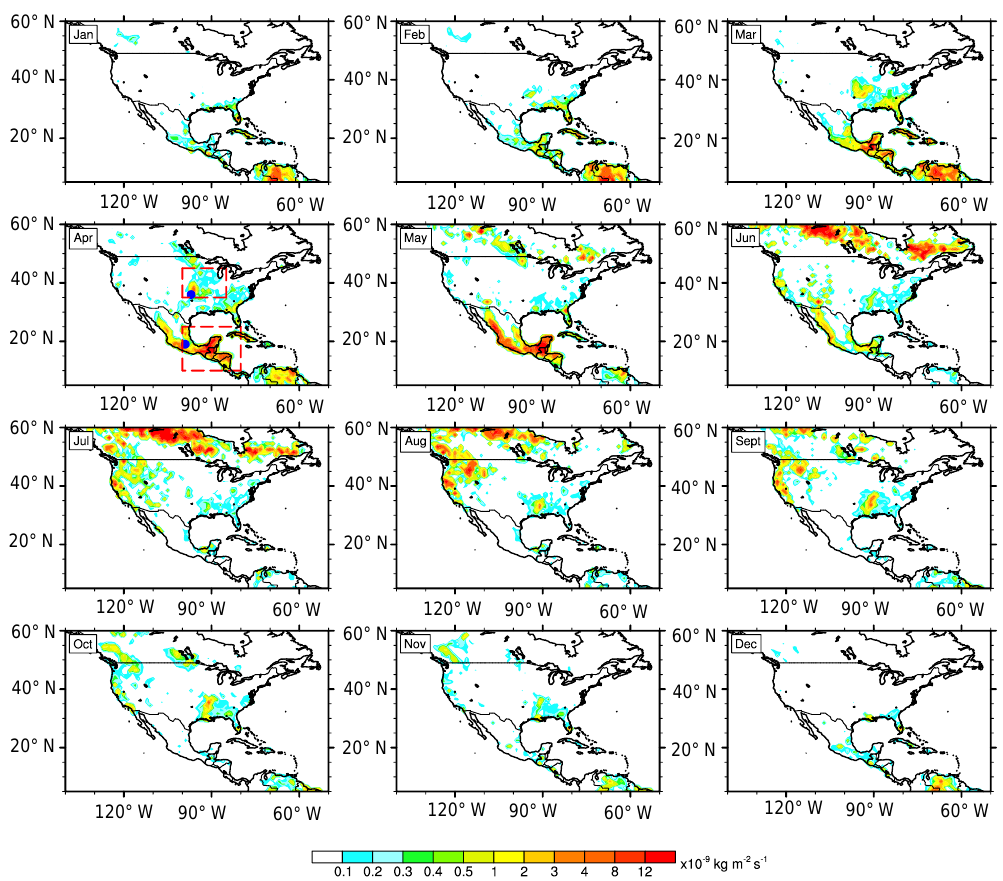
Figure 1. Spatial distributions of multi-year monthly mean biomass-burning-consumed dry matter over North America during 2003–2014 from GFEDv4.1. Boxes denote selected regions: central US (35–45 ◦ N, 85–100 ◦ W) and southern Mexico (10–25 ◦ N, 80–100 ◦ W). Dots denote locations of AERONET sites: CART site (36 ◦ N, 97 ◦ W) and Mexico City (19 ◦ N, 99 ◦ W).